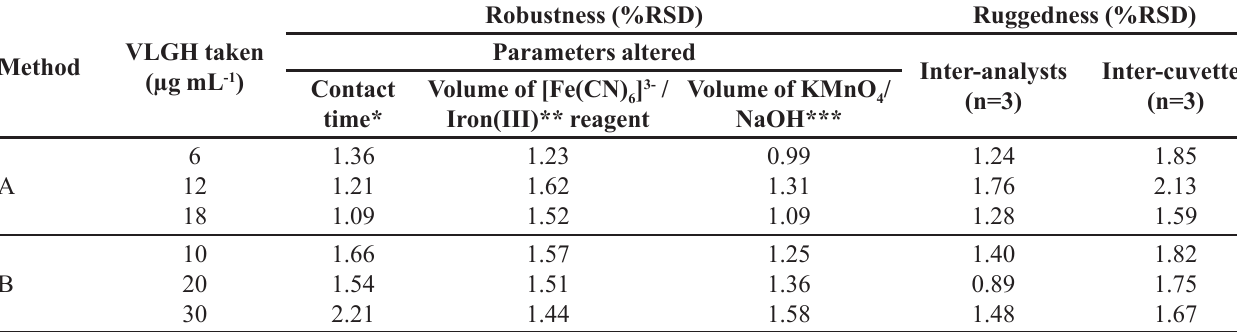
TABLE III - Method robustness and ruggedness expressed as intermediate precision (% RSD)